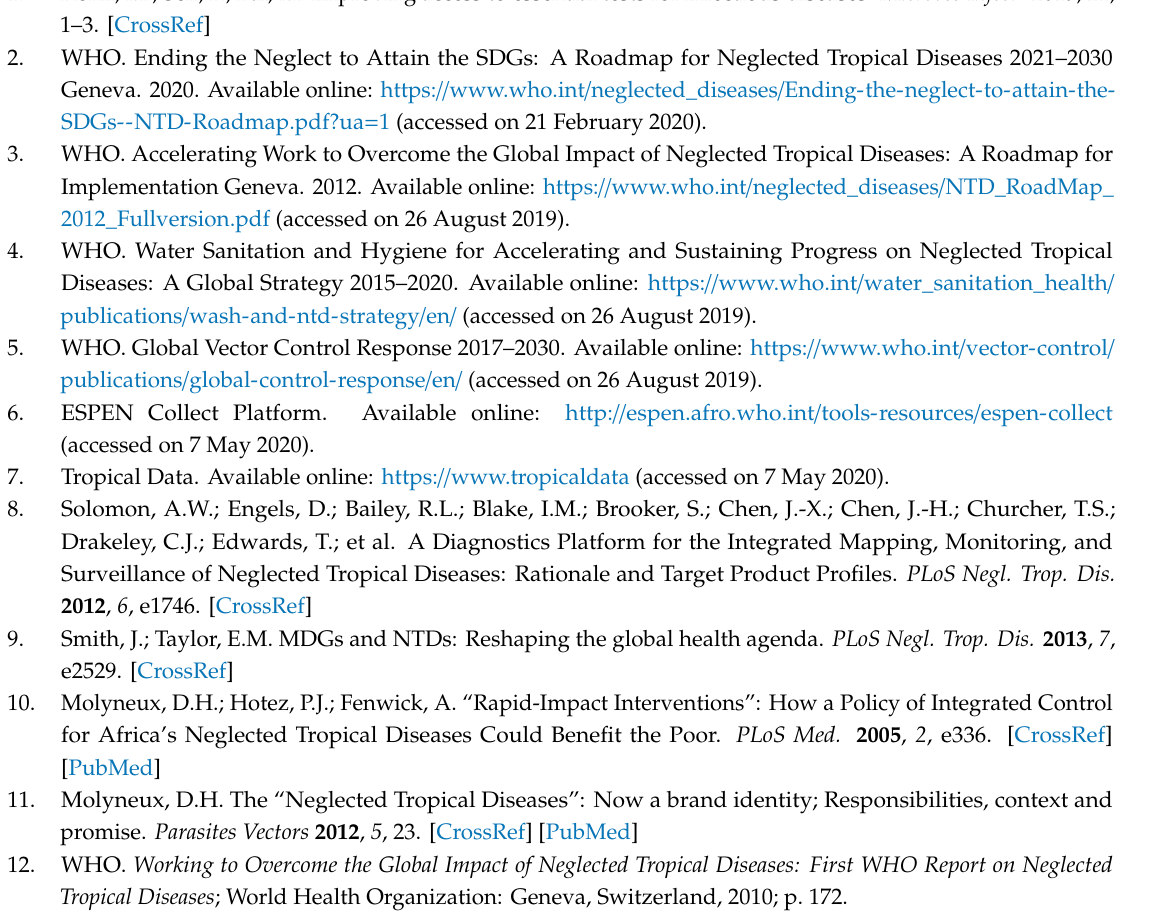
Table S1: NTDiagnostics_Included studies; File S1: Overview WoS results_search strings, dates and